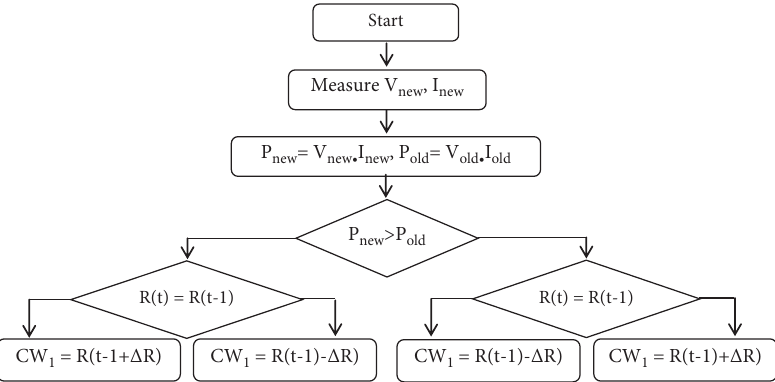
Figure 9: Flow chart for the P and O method.